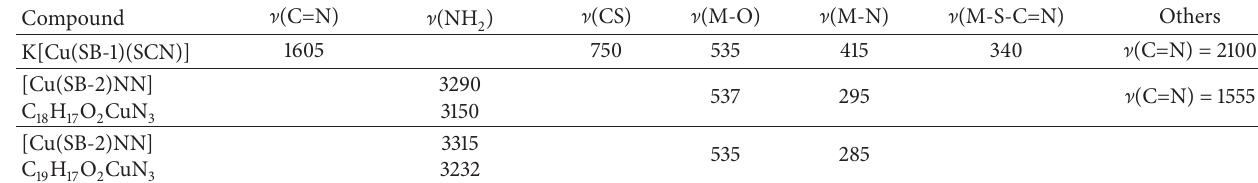
Table 2: Selected IR spectral data of the complexes (band maxima, cm −1 ).